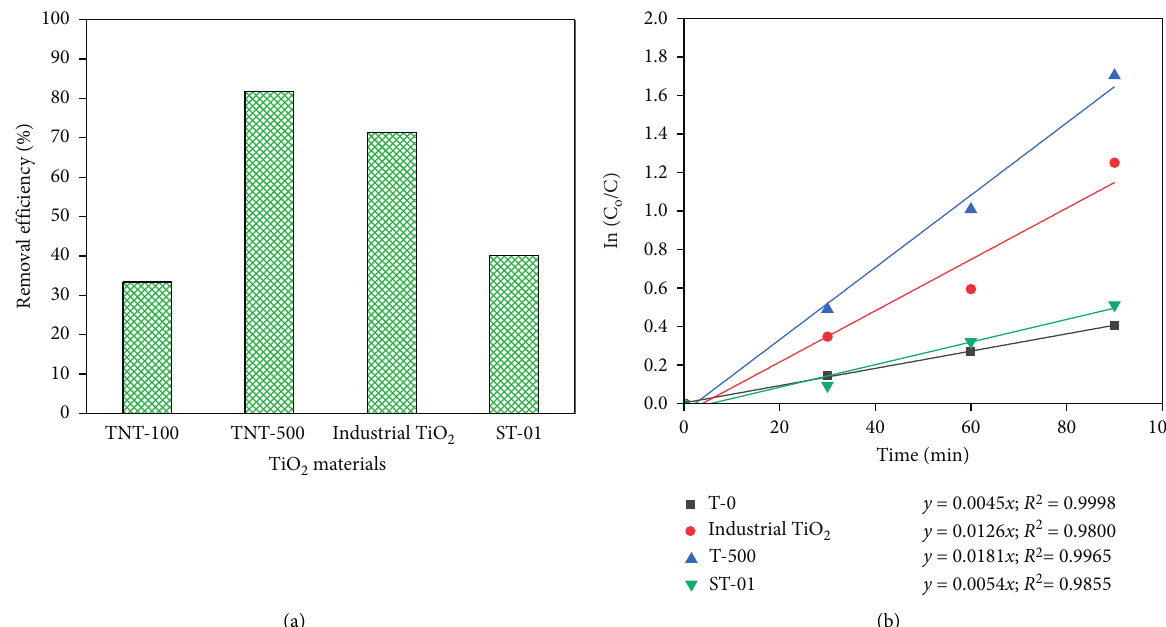
Figure 2: Procion MX removal efficiency (a) and pseudo-first-order kinetics fitting (b) of different TiO UV-A light bulb, after